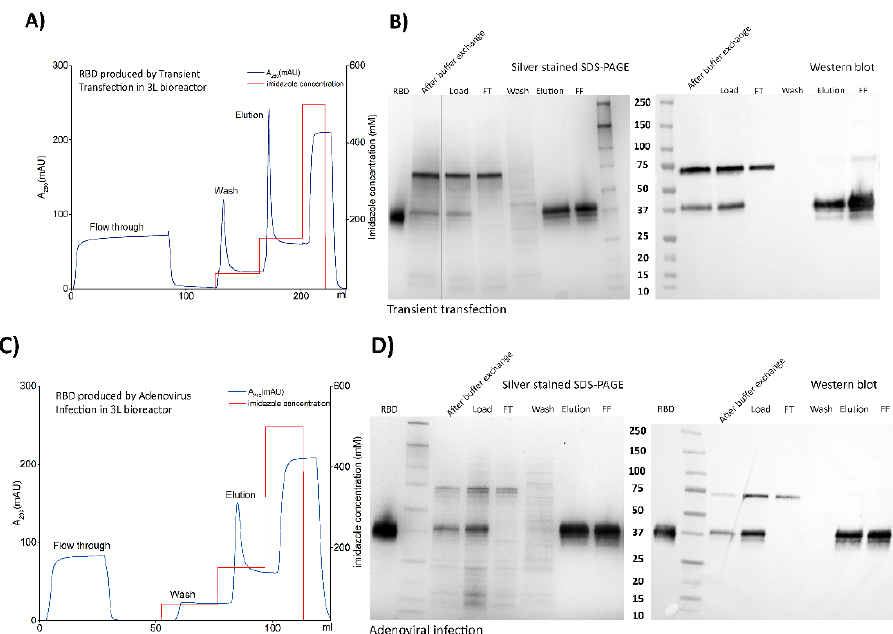
Figure 3. Downstream processing conducted for recovery and purification of the RBD transiently expressed in 3L-controlled bioreactors following two di ff erent strategies. ( A ) Chromatogram of IMAC purification of RBD in culture supernatant produced from plasmid DNA transfection of HEK293SF cells. Main purification steps are indicated by UV absorbance at 280 nm and they comprise the flow-through after loading the column, a washing step and elution of purified RBD. ( B ) Analysis by silver stained SDS-PAGE and Western blot using an anti-Spike polyclonal antibody of di ff erent fractions from the RBD separation and purification steps, after transient transfection of HEK293SF cells. The samples corresponding to steps or fractions such as bu ff er exchange (to eliminate the HyCell-TransFx-H medium), loading, flow through (FT), wash, elution and final formulation (FF) appear in both panels in which the RBD can be observed with a high degree of purity at a molecular weight of around 38 kDa. ( C ) Chromatogram of IMAC purification of RBD in culture supernatant produced from adenoviral infection of HEK293SF cells. The main purification steps of RBD are indicated by UV absorbance at 280 nm. ( D ) Silver stained SDS-PAGE and Western blot analysis of samples and fractions collected from an identical purification process as the one described in ( A , B ). The molecular weight marker used and reference RBD are also shown in the figure. Table 3. RBD expression levels and recovery determined by ELISA in samples collected during RBD purification from the supernatant of transfected HEK293SF cells cultured in suspension in a 3L bioreactor.